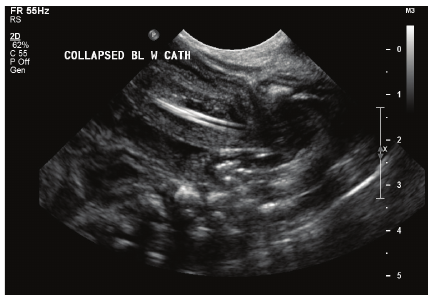
Figure 1: Catheter visualized with tip protruding through the dome of bladder.